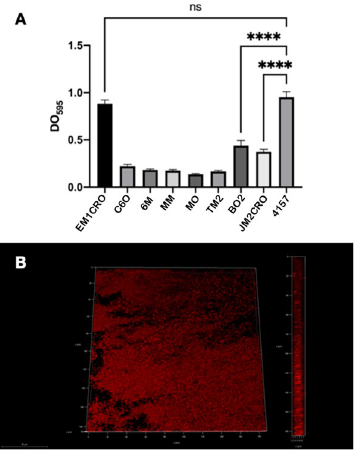
Figure 6. Biofilm formation by critical priority WHO Enterobacterales from isolated from wild edible marine bivalves. In A , crystal violet assay, after 24 h incubation at 37 °C in BHI medium. The values correspond to the average of three independent triplicates; p values < 0.001 were considered significant. Strains were considered to form weak, moderate, or strong biofilms, compared to a strong biofilm-forming E. coli strain (4157); In B